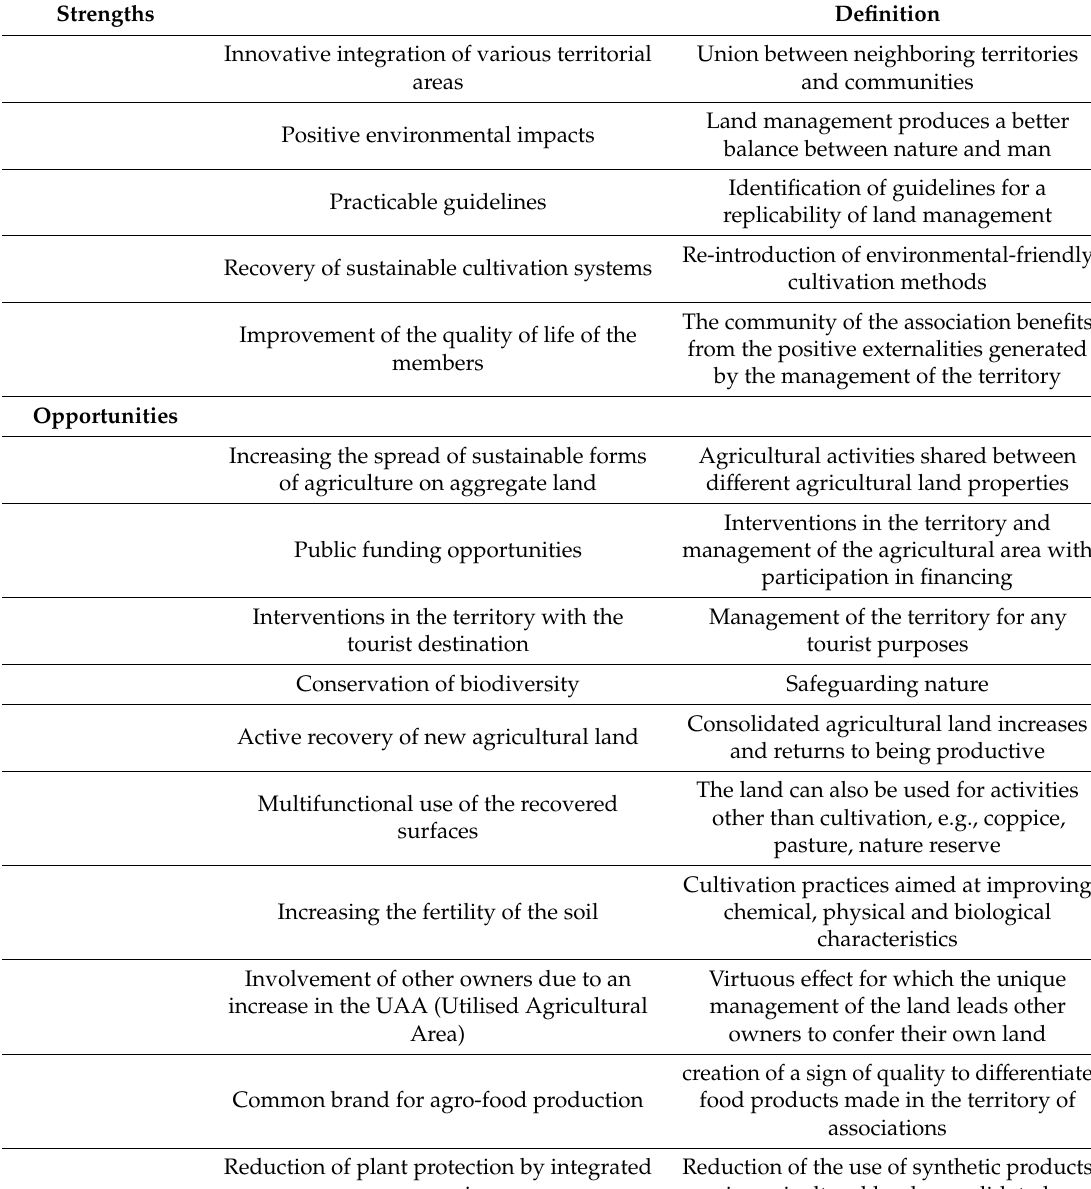
Table 2. Strengths and opportunities that emerged from the literature